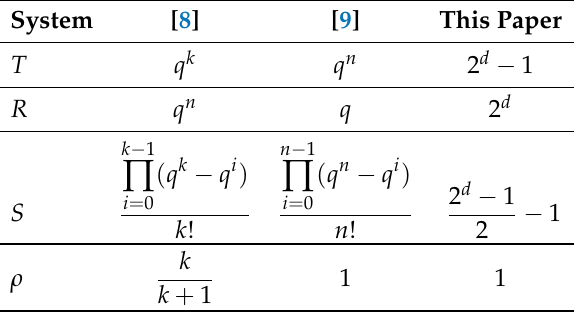
Table 1. Comparison